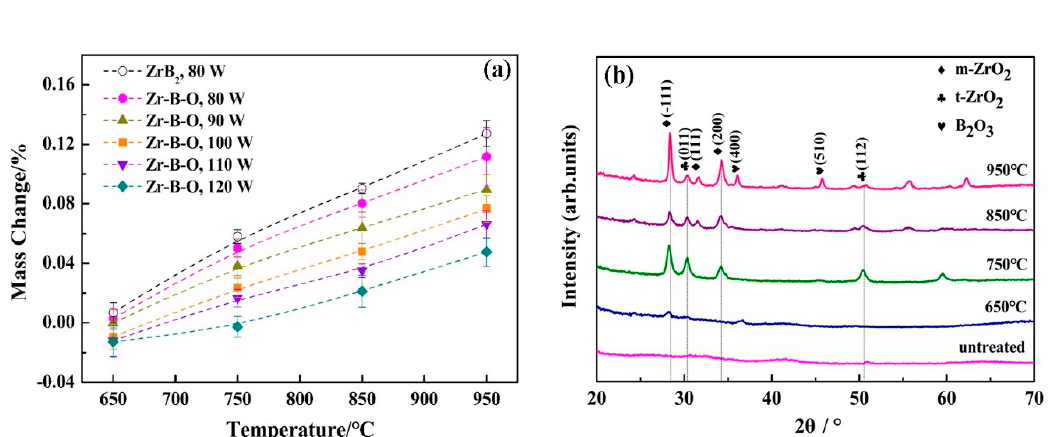
Figure 7. Fitting curves of ( a ) oxidation-mass change and ( b ) XRD patterns of Zr-B-O nanocomposite films (120 W power of ZrB 2 target) at different testing temperatures.